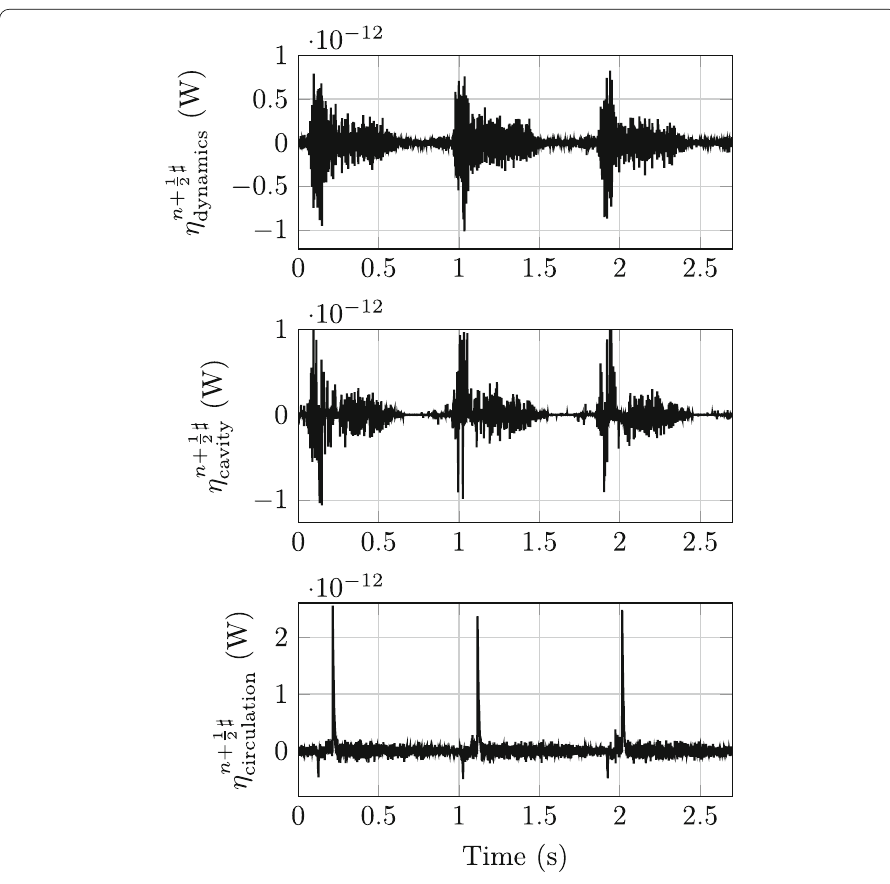
Fig. 8 Illustration that the energy balances are satisfied at the discrete level. The energy conservation residuals (66), (77) and (79) are evaluated numerically over time